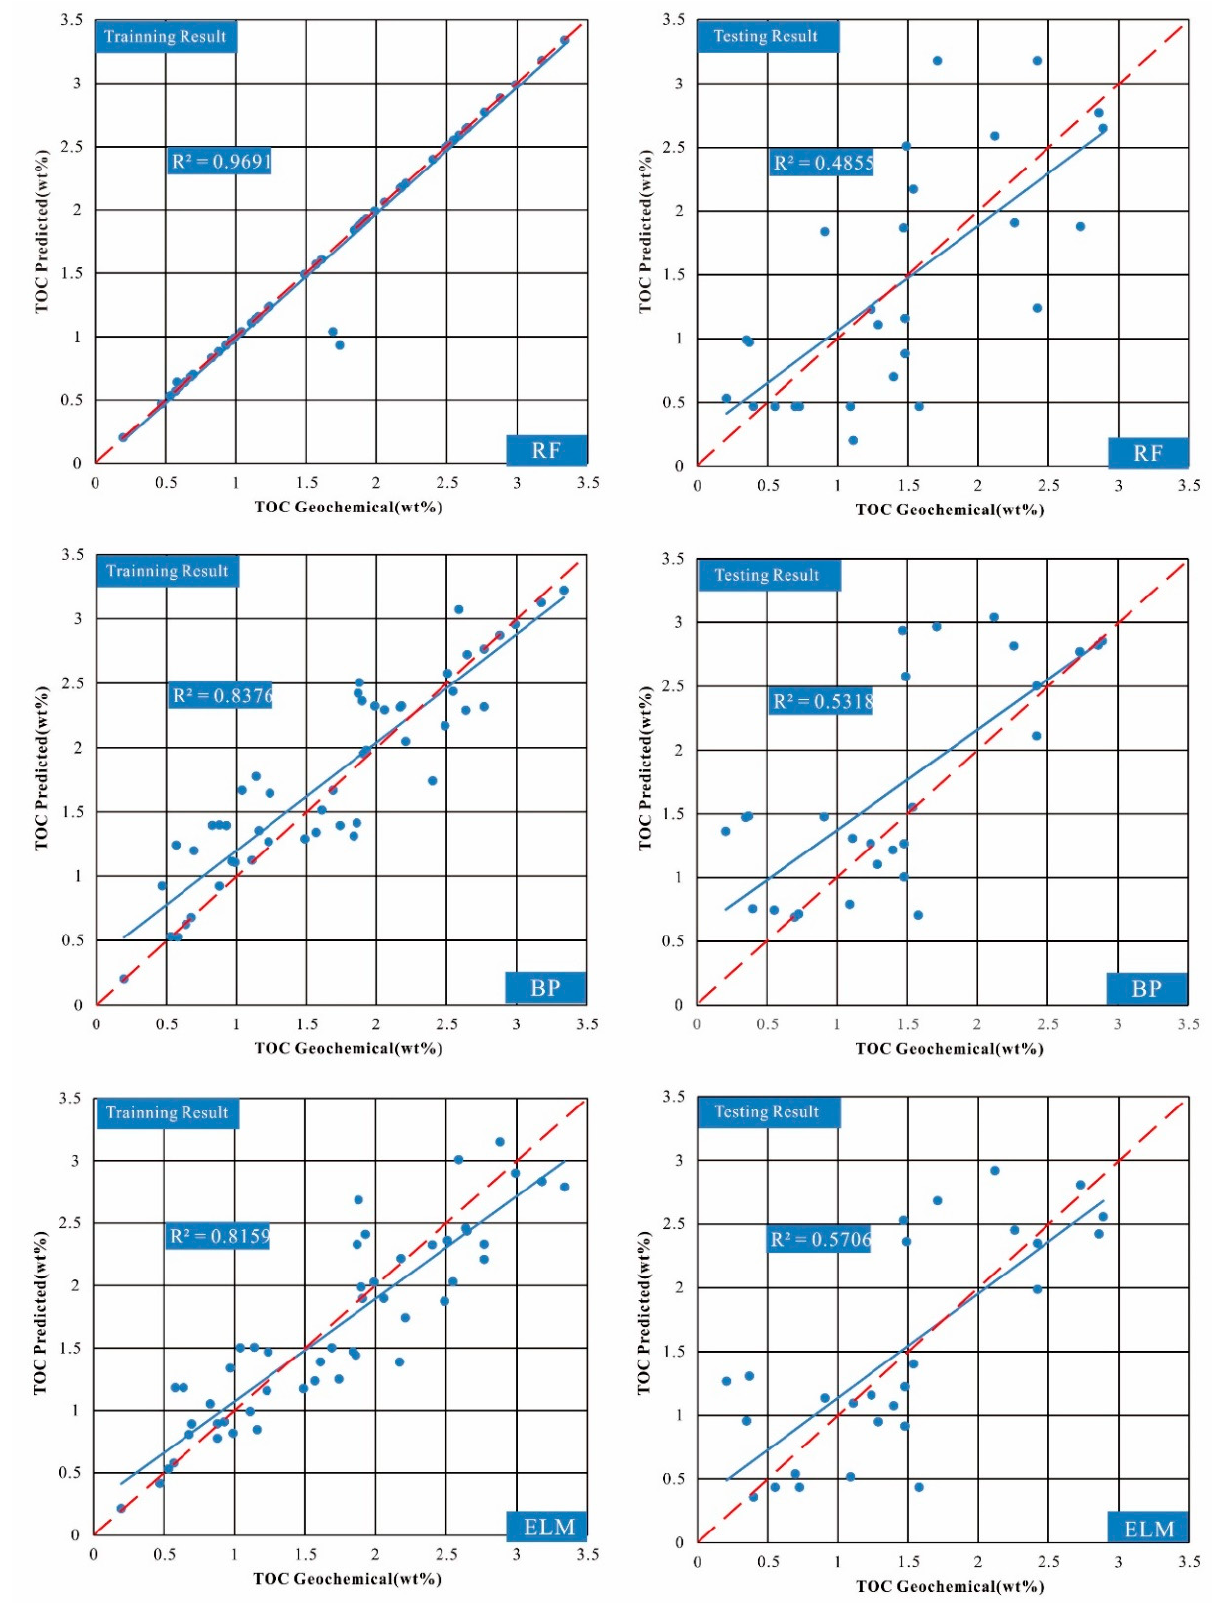
Figure 9. Cross plots between TOC values from ML models using HX and TOC values from core data.